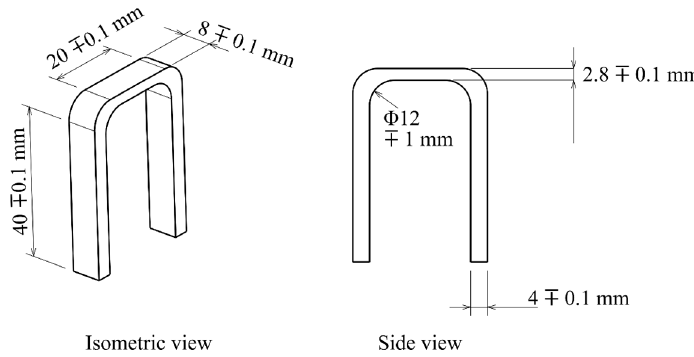
Figure 4. Linear rectangular cross-section coil.